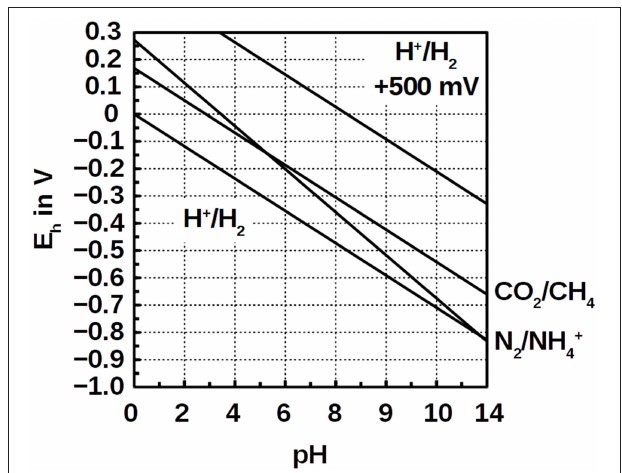
FIGURE 1 | Pourbaix diagram of the redox couples H + /H 2 , N 2 /NH + 4 , CO 2 /CH 4 , and the hypothetical potential of H + /H 2 at + 500mV (order from negative E h to